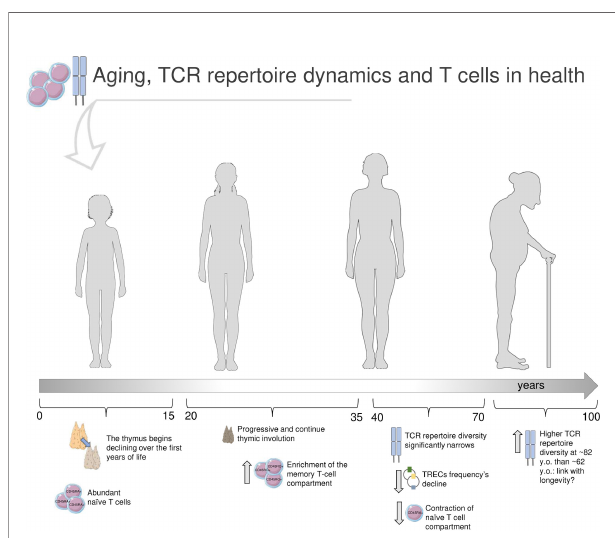
FIGURE 1 | Immunosenescence and T-cell receptor repertoire in health. In the fi rst years of life, the thymus is at its maximum size and activity, and the T-cell compartment is characterized by abundance of naïve (CD45RA+) CD4+ and CD8+ cells. Earlier in life, the thymus starts to shrink, and continues to decline over puberty and adulthood, alongside with changes in the T-cell compartment, now enriched in memory (CD45RO+) cells (23 – 27). The TCR repertoire diversity signi fi cantly narrows after the age of 40 years old (y.o.) (1, 2, 4). The strongly reduced thymic output re fl ects in a decline of T-cell receptor excision circles (TRECs) frequency, small molecules of circular DNA representative of T-cell maturation (27). Furthermore, the naïve T-cell compartment results signi fi cantly dwindled (23 – 27). Through the latest stages of life, some TCR b clones, especially across memory repertoires, are de fi nitely predominant; interestingly, Britanova et al. documented a higher TCR repertoire diversity in older people (average age of 82 y.o.) compared to 62 y.o. individuals, that may be suggestive of longevity (4). Parts of the image created using pictures adapted from Servier Medical Art